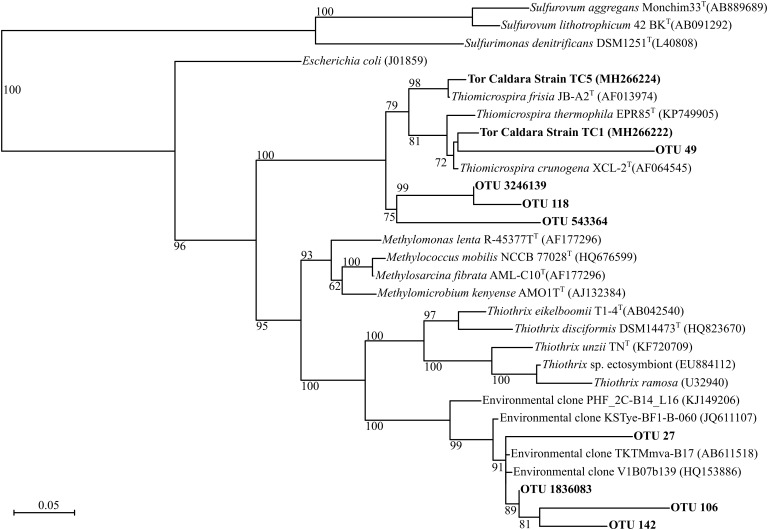
Maximum-likelihood phylogenetic tree derived from V4 regions and full length 16S rRNA gene sequences showing the positions of three Thiothrix-like CF-26 OTUs, three Thiomicrospira OTUs and Thiomicrospira strains TC1 and TC5 within the Gammaproteobacteria. aLRT branch support values higher than 50% were based on 1000 replicates and are shown at each node. Bar, 0.05% substitutions per position. Sequences belonging to the class Epsilonproteobacteria were used as outgroup.